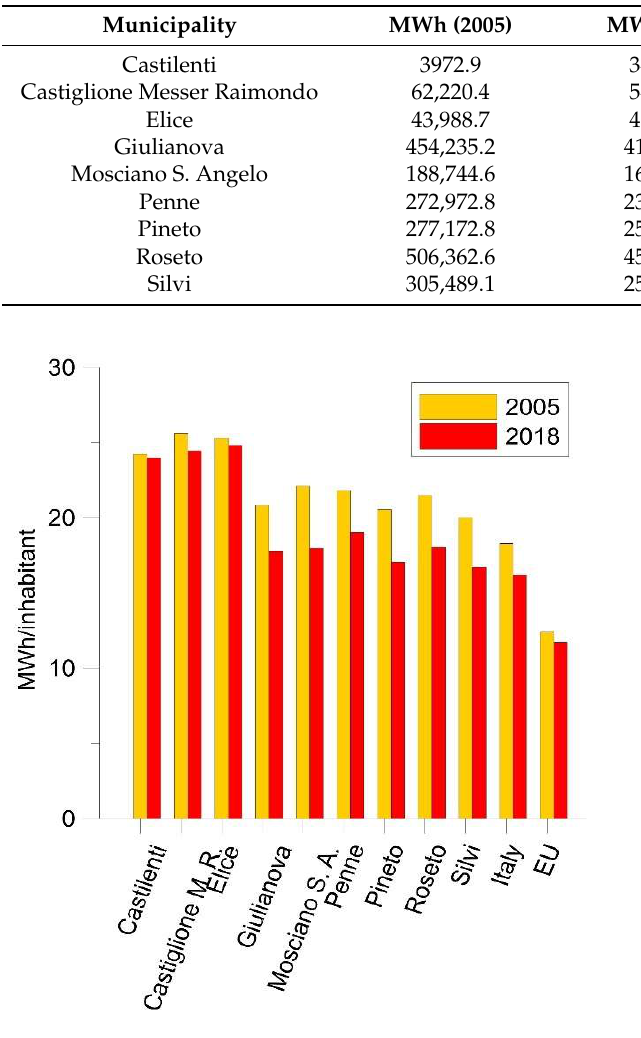
Figure 5. Comparison of per capita consumption between 2005 and 2018.